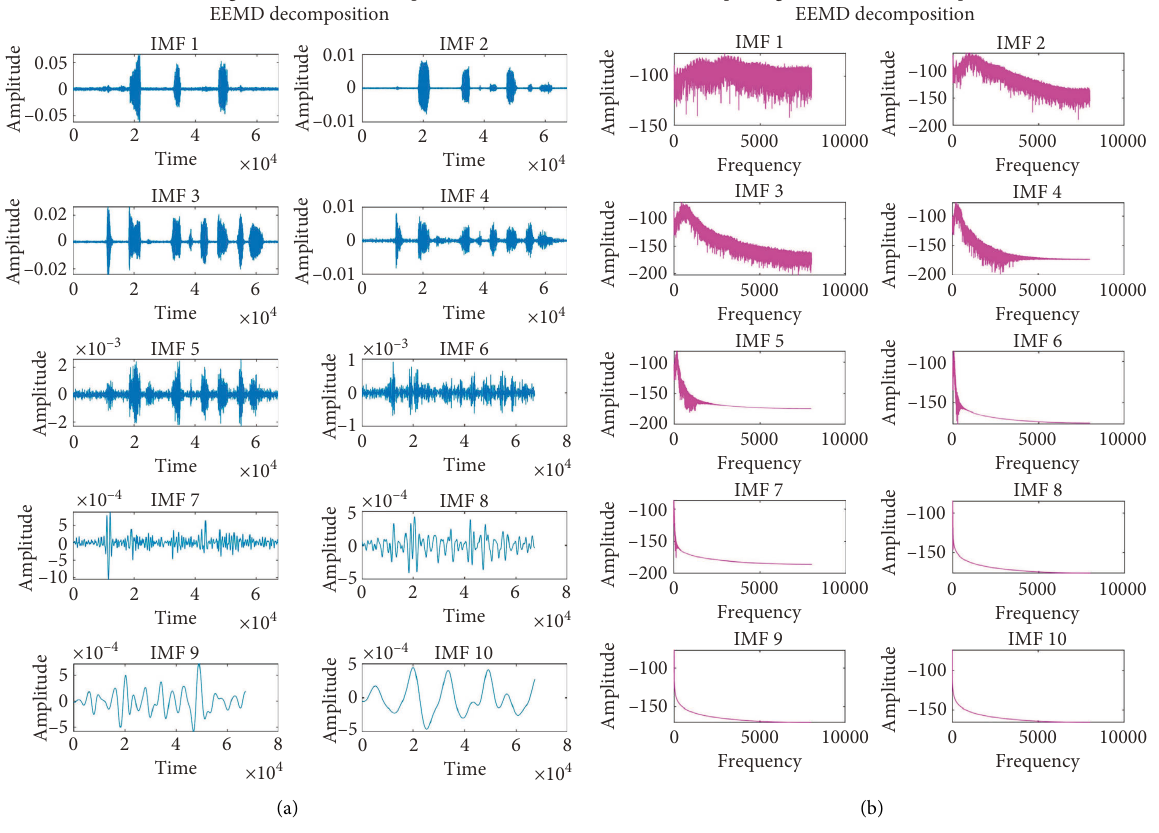
Figure 7: IMF components after EEMD decomposition. (a) Time domain diagram. (b) mean square error less than 0.0074 are selected for recon- decomposed, and the decomposed IMF components and the struction, and the adaptive reconstruction process is shown in remaining components and the corresponding spectrum are Figures 9 and 10. According to the result of adaptive re- shown in Figure 7; the IMF components are distinguished construction, the components IMF1, IMF2, and IMF3 are according to frequency, it is divided into high-frequency selected for reconstruction. Figure 11 shows the comparison component, low-frequency component, and trend quantity. diagram of the signal before decomposition and the recon- The time domain diagram of each component is shown in structed signal and the reconstruction error diagram. Figure 8. Figure 12 shows the comparison of original signal with The correlation coefficient and root mean square error of the original signal with noise and the signal processed by each IMF component and residual component and the NLM-EEMD; it can be seen that the denoising effect is very original signal are calculated, and then the adaptive threshold obvious, and the original signal characteristics are basically λ of 0.2692 and δ of 0.0074 are obtained. The IMF compo- restored. nents with correlation coefficient greater than 0.2692 and root